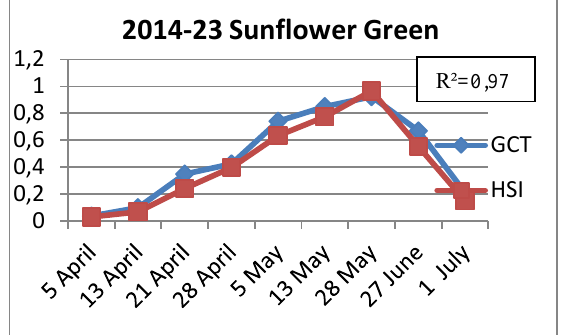
Figure 1. An example for digital camera images of 2014-23, sunflower plant images transformed RGB to HSI .